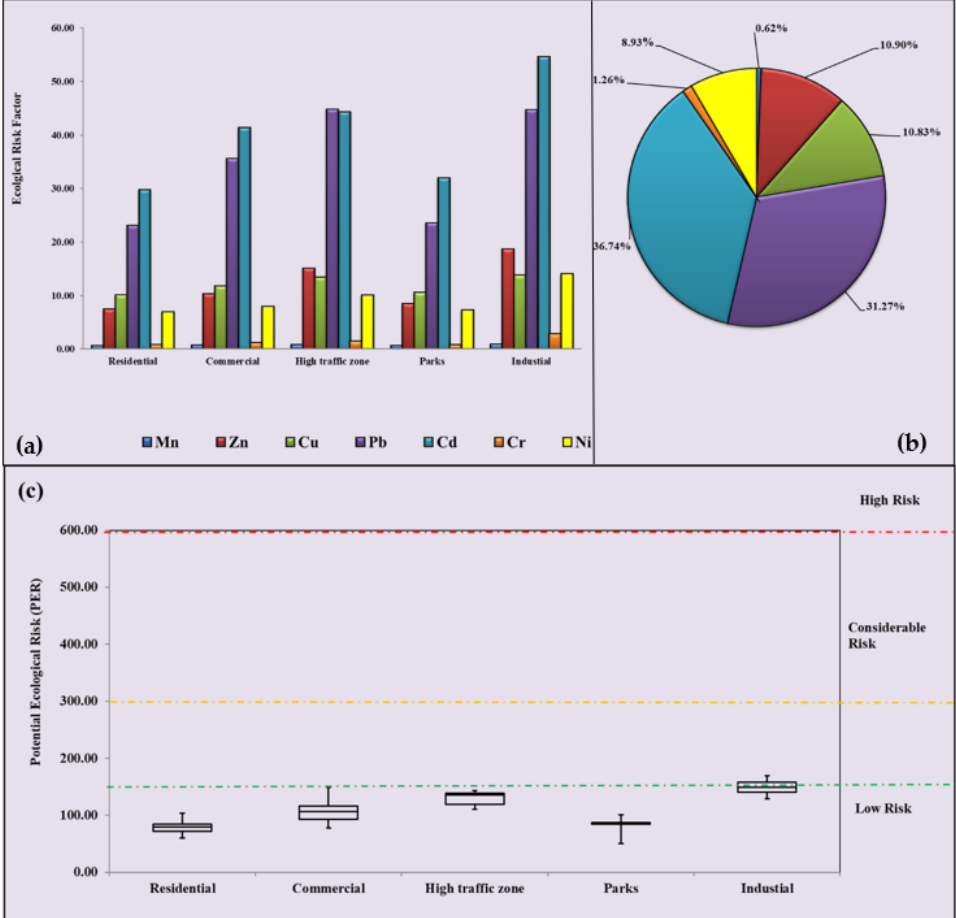
Figure 5. ( a ) Ecological risk factors (E r ) of individual HMs in different functional areas; ( b ) relative percentage contributions of heavy metals to the potential ecological risk index (PER) in Lucknow; ( c ) box plot of potential ecological risk (PER). The box plot is outlined by the 25th and 75th percentile values, whiskers indicate the 10th and 90th percentile values, and dots show the 5th and 95th percentile outliers. The solid black line within the box corresponds to the 50th percentile value (or the median). Table 8. Summary of hazard quotient (HQ) and hazard index (HI) values of HMs in road dust for five different functional areas.